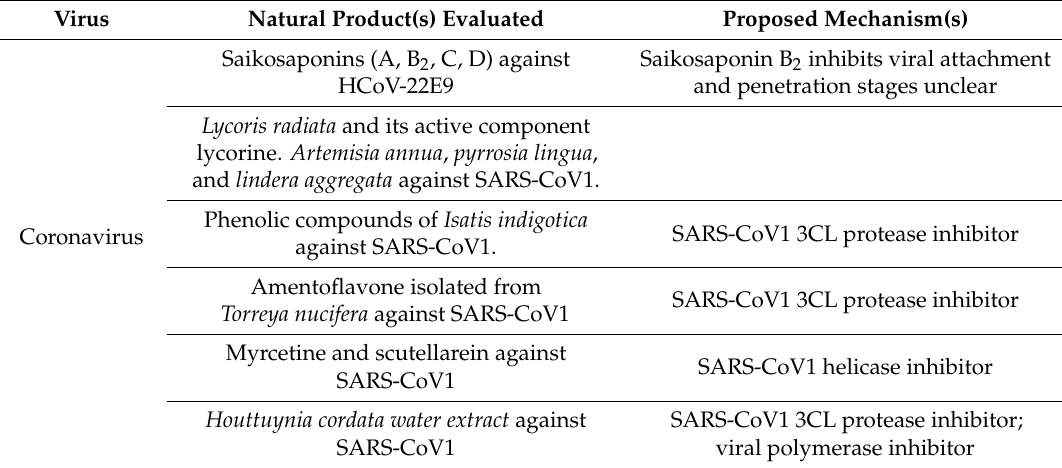
Table 1. Antiviral e ff ects of several natural products against